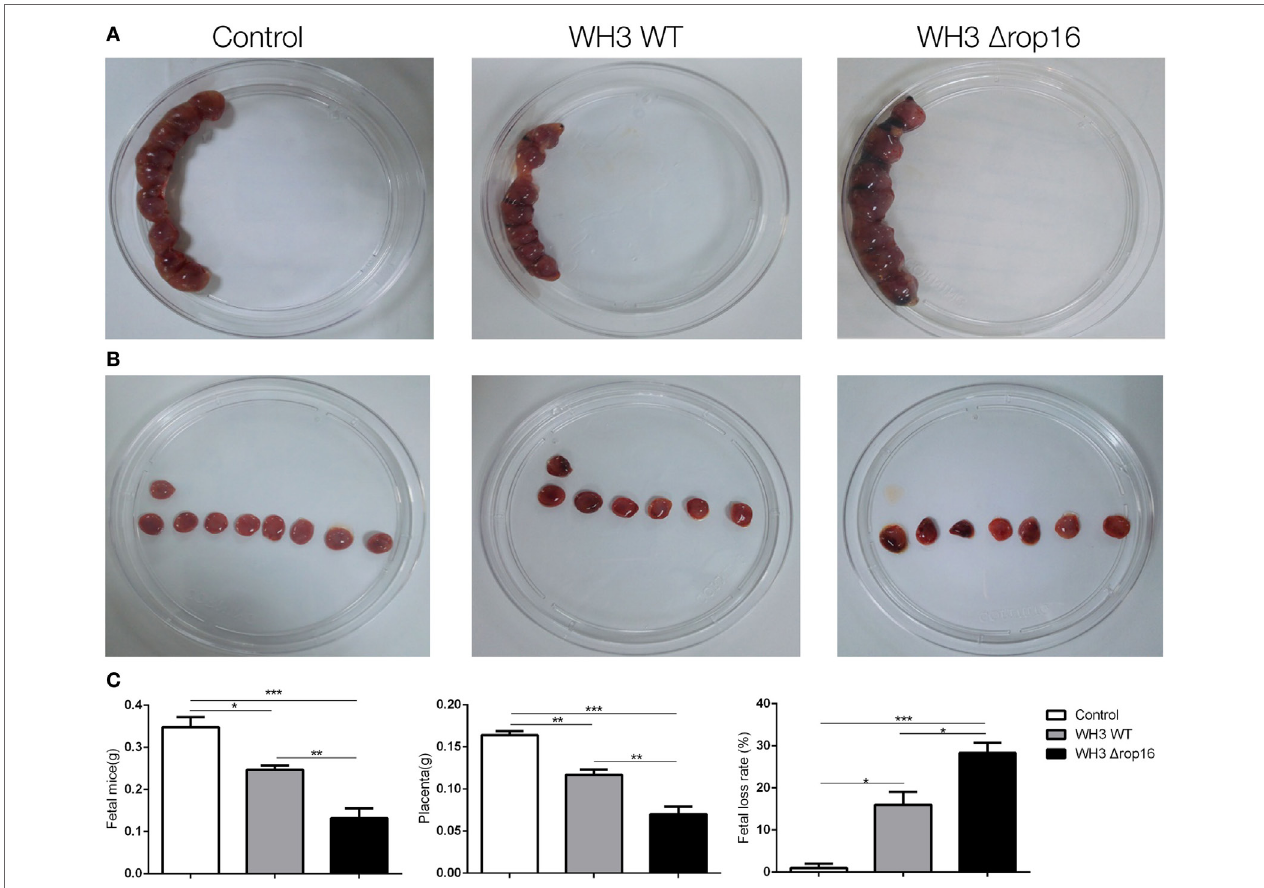
FigUre 3 | Toxoplasma gondii infection induced adverse pregnancy outcomes in mice. (a,B) The uteruses of WH3 Δ rop16 -infected mice presented notable fetal resorption and placental bleeding in comparison with the WH3 WT group. (c) The weights of fetuses, placentas, and rate of fetal loss were measured at day 6 post infection. The fetal loss rate was calculated by ratio of resorption sites to the total number of implantation sites. (* p < 0.05, ** p < 0.01, *** p <